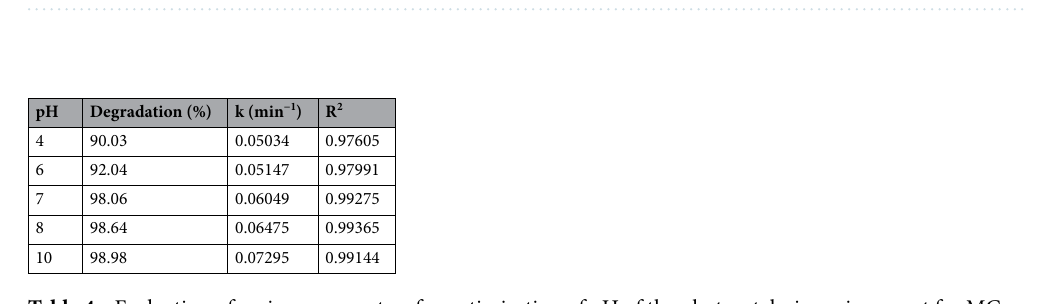
Figure 11. ( a ) Degradation profile and ( b ) kinetics plot for MG dye degradation at various pH environments.